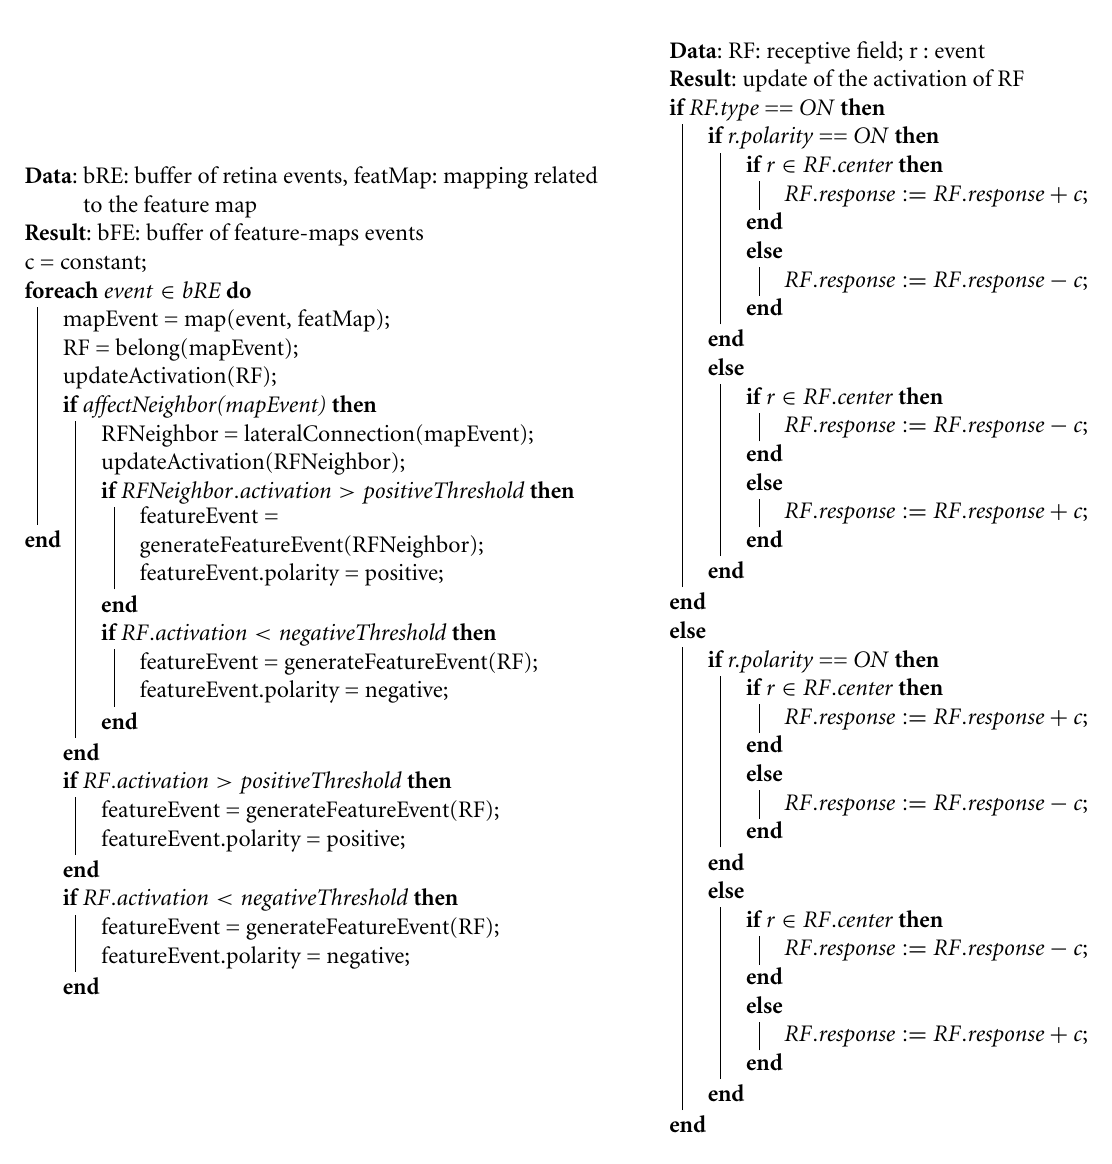
FIGURE 2 | Receptive fields of cells used for the mapping procedure: center-surround cells. (A) Four 4 × 4 cells, (B) one 8 × 8 cell. Simple oriented cells: (C) two 4 × 4 cells, (D) one